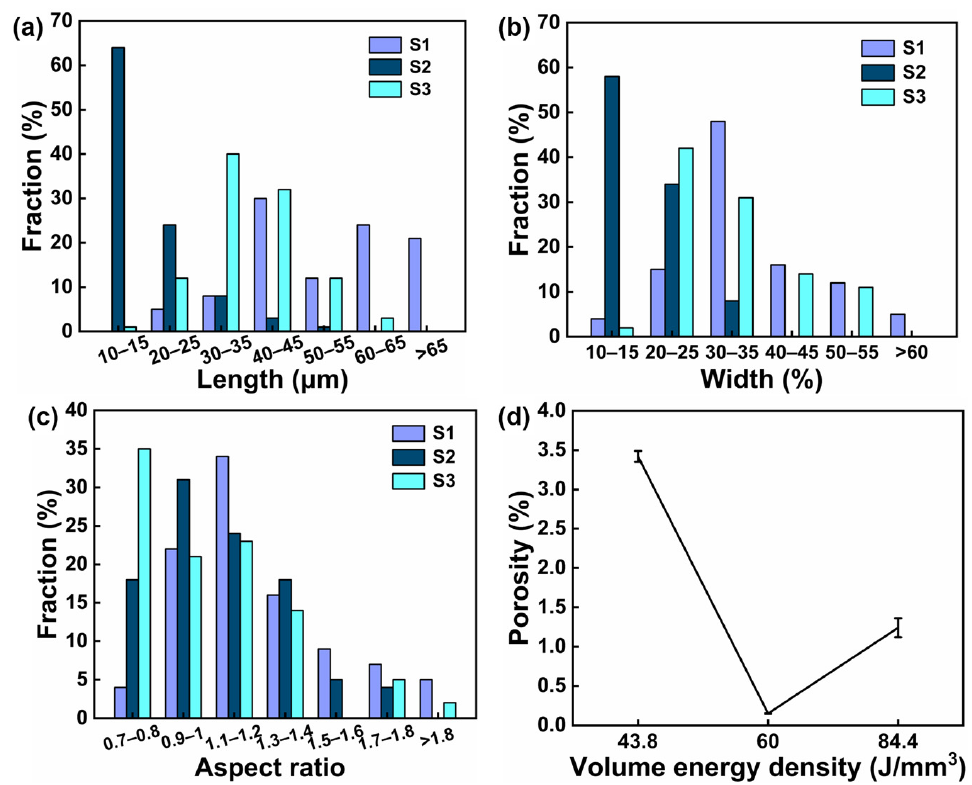
Figure 4. The statistical results of pores with different VED: ( a ) length; ( b ) width; ( c ) aspect ratio; ( d ) porosity.